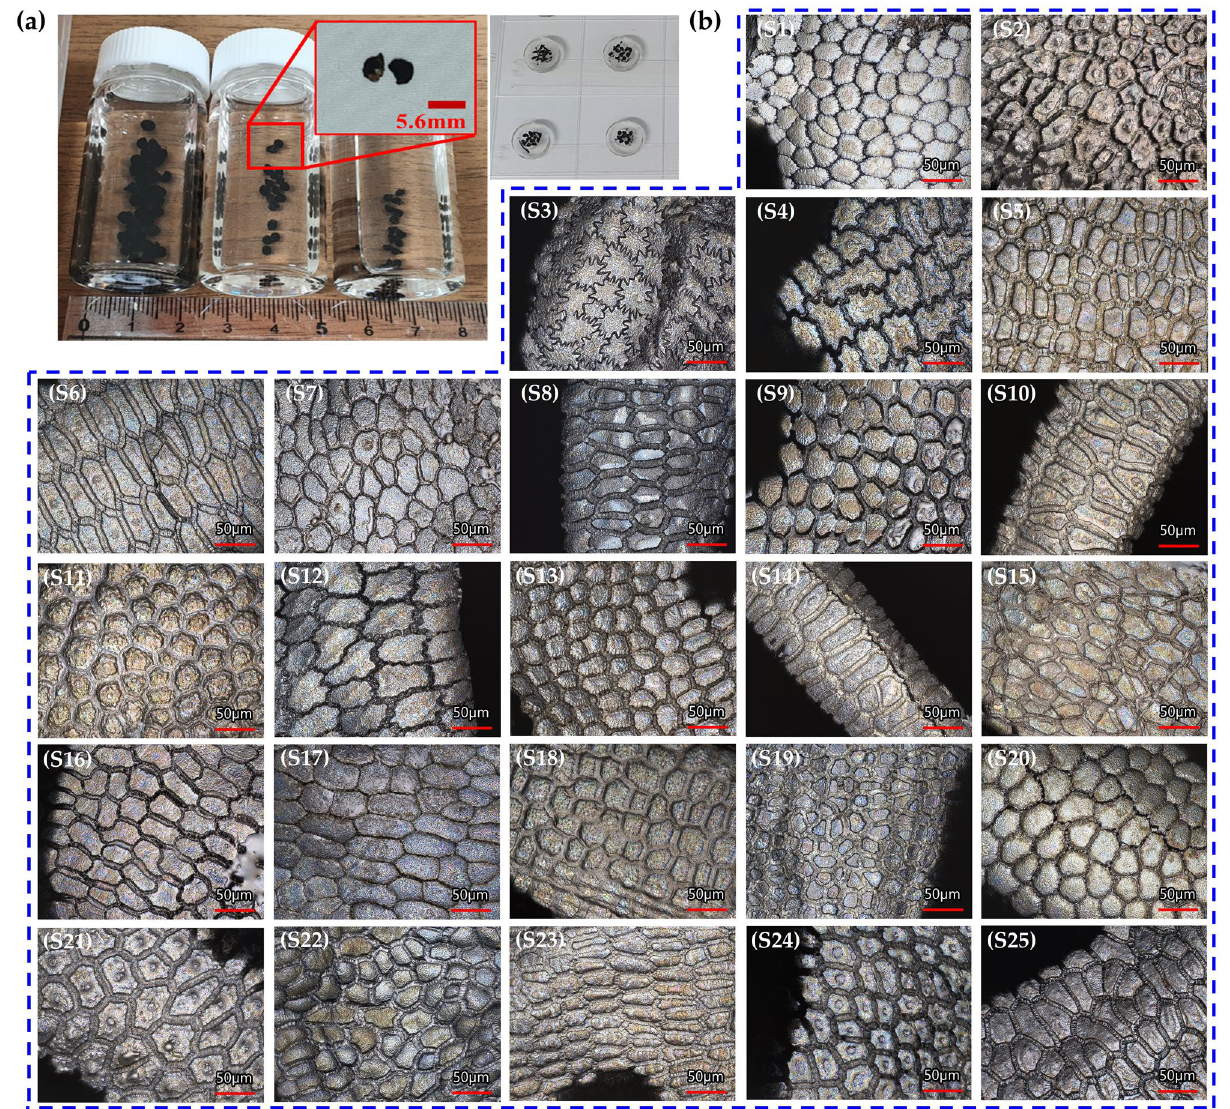
Figure 1. Microscope images of Allium seeds; ( a ) Image of Allium seed specimens and ( b ) microscope images of Allium seeds samples